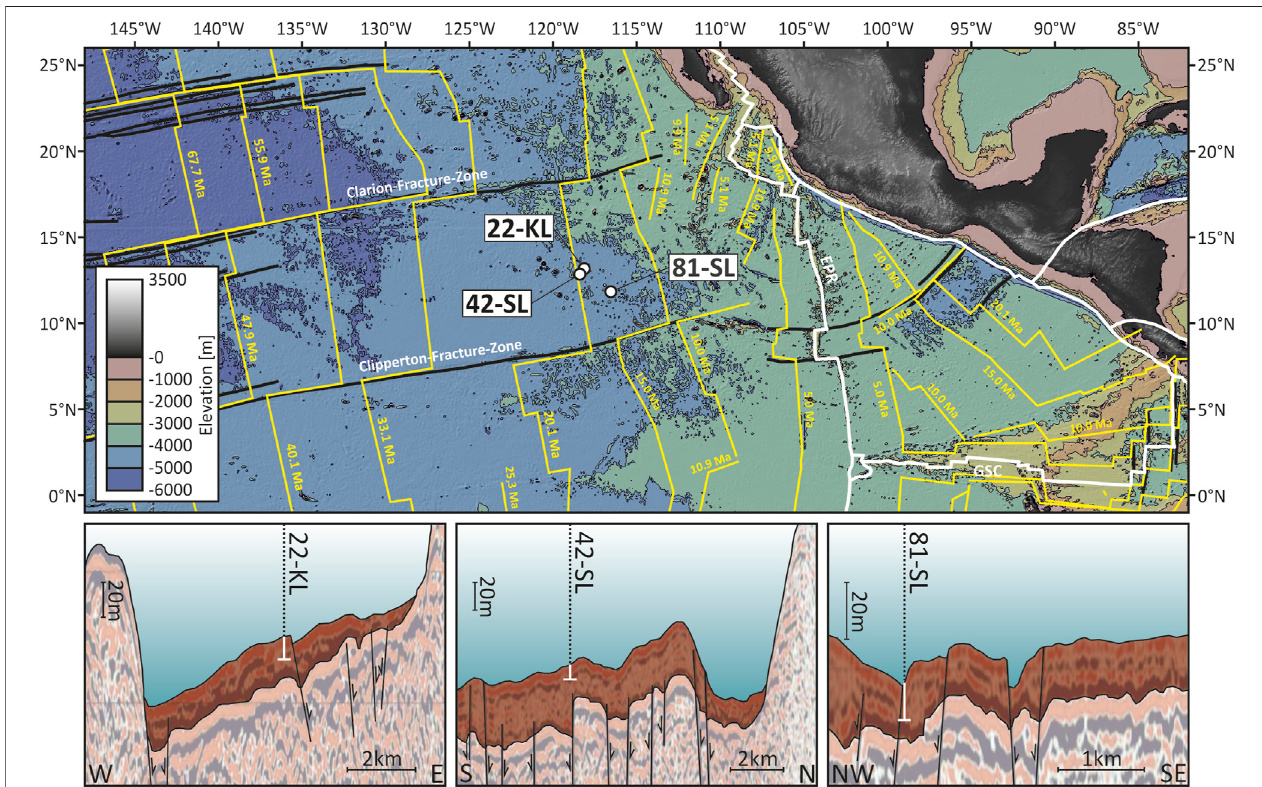
FIGURE 1 | Bathymetric overview of the eastern low-latitude North Paci fi c with the three SO-240 coring sites of interest here (Kuhn et al., 2015). Crustal age isochrones(yellowlines)weredrawnafter Mülleretal.(2016),plateboundaries(whitelines)and majorfracturezones(blacklines)followinterpretationsof Matthews etal. (2011). The three interpreted sections at the bottom show seismic pro fi les through the coring sites with associated fault structures modi fi ed from Kuhn et al. (2015). The shallow sediment cover above the crust is highlighted in brown. White markers depict the approximate penetration depth of the recovered sediment cores.